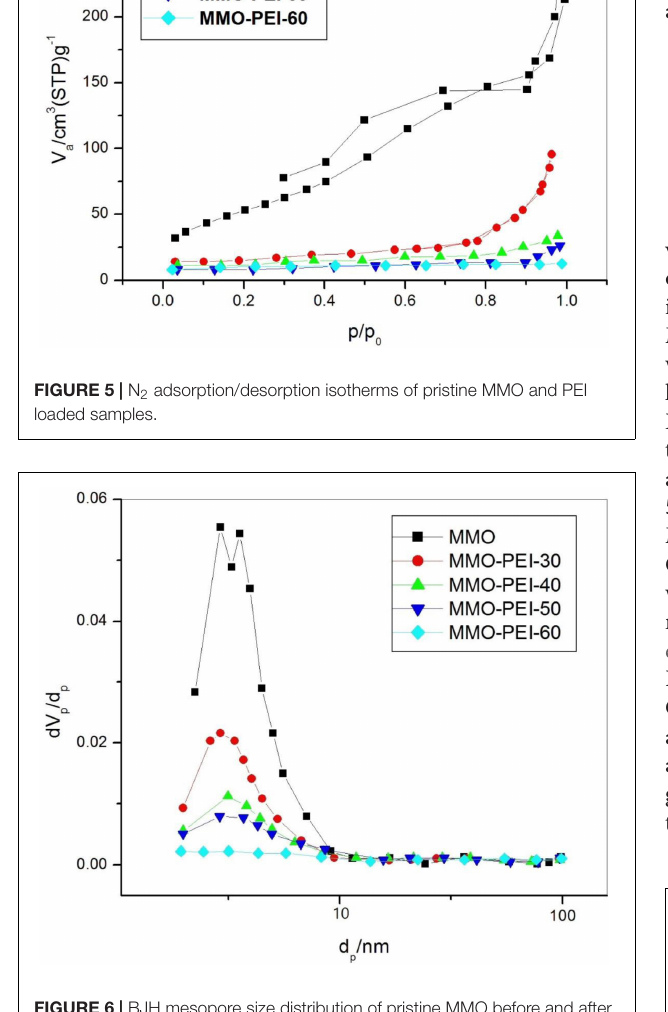
FIGURE 6 | BJH mesopore size distribution of pristine MMO before and after PEI impregnation.